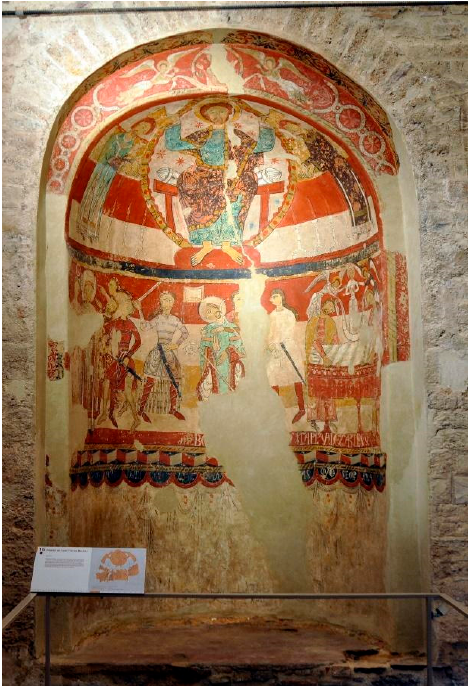
Figure 1. Wall paintings at Santa Maria de Terrassa. General view of the chapel. © Photo: Car- les S á